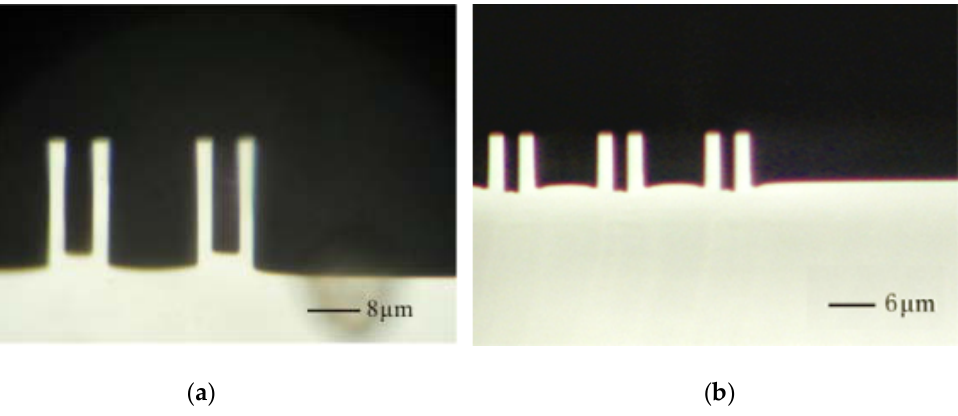
Figure 7. Cross-section views of DRIE results. All of the geometric parameters of the test structure are identical. ( a ) Lag effect; ( b ) Anti-lag effect.